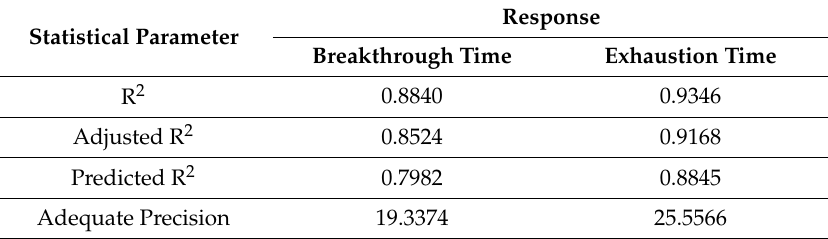
Model-fitting statistical details for logarithmic linear toluene breakthrough and exhaustion